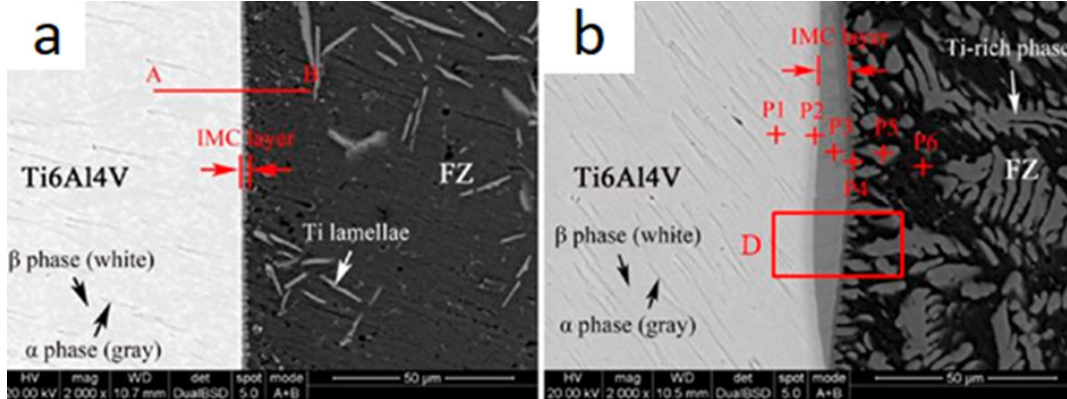
Figure 16. SEM image of the C ( a ) and A ( b ) region in Figure 15 a [27].